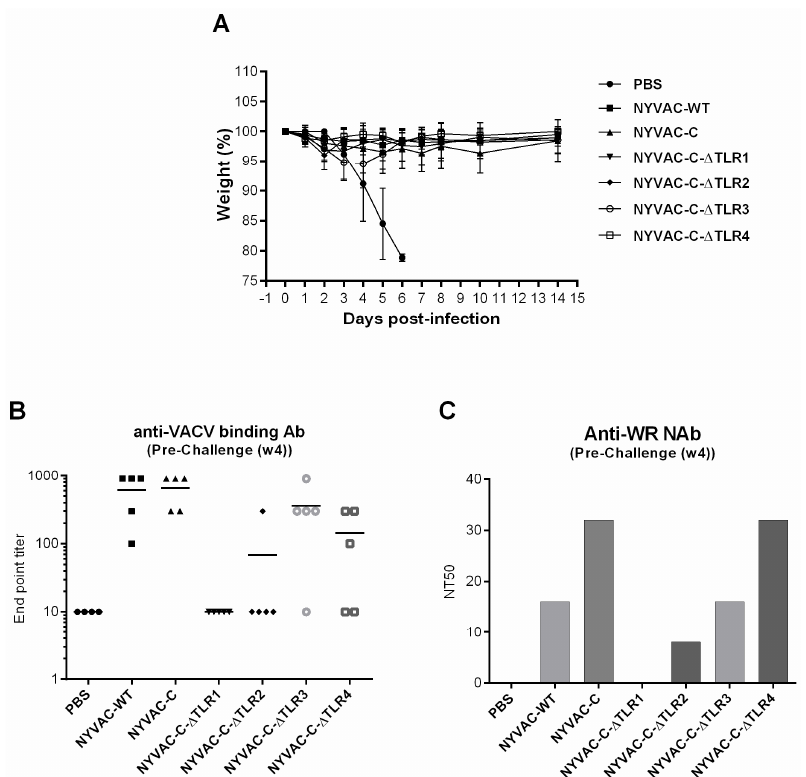
Figure 6. Vaccine efficacy of recombinant NYVAC-C viruses after single or sequential deletion of VACV-TLR inhibitors A46R , A52R , K7R and B15R . ( A ) Groups of five BALB/c mice were vaccinated by i.p. inoculation with 10 7 pfu of the indicated viruses and challenged i.n. one month later with 5 × 10 6 pfu of wild-type VACV WR. The resulting weight change was monitored daily. Data are expressed as the percentage ± standard error of the mean (SEM) of the mean weight of the same group of animals on day 0. ( B ) VACV-specific antibody titres and ( C ) VACV-specific neutralizing titres measured by ELISA and plaque reduction neutralization, respectively, in serum from immunized mice before the i.n. challenge.